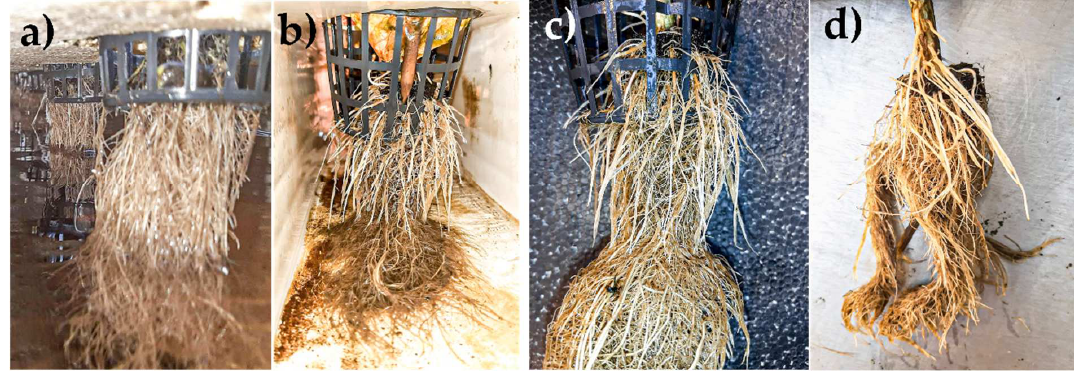
Figure 5. Weekly increase of ( a ) shoot axis length (cm) and ( b ) number of leaves of Ocimum basilicum in DRF, raft, and AERO hydroponic subsystems over the trial period (39 days). From the fourth week of the experiment, the AERO system showed increased growth performance.